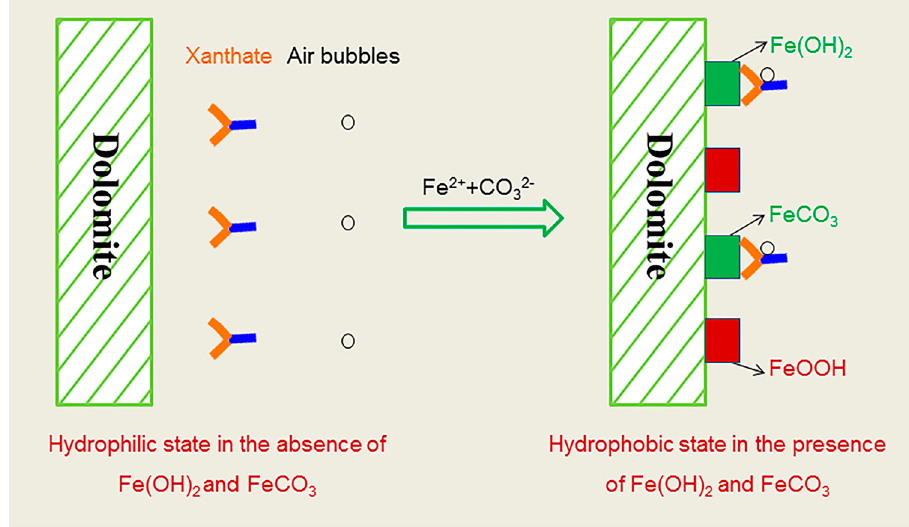
Figure 10. Schematic presentation of Fe(OH) 2 and FeCO 3 activated dolomite flotation.